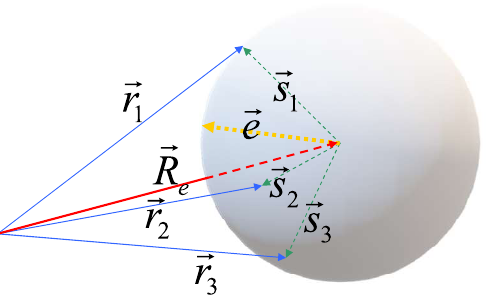
Figure 7. The retrieved positions (cid:126) r i are determined with respect to the sensor array frame. A large set (cid:126) R (cid:126) r e , and hence the positions (cid:126) s i with respect to the i might enable the determination of the eye center eye center. The gaze orientation (cid:126) e moves rigidly with the position (cid:126) s of the magnet, and (cid:126) s could be used alternatively to (or in conjunction with) (cid:126) m to determine (cid:126) e . This requires that (cid:126) R e is